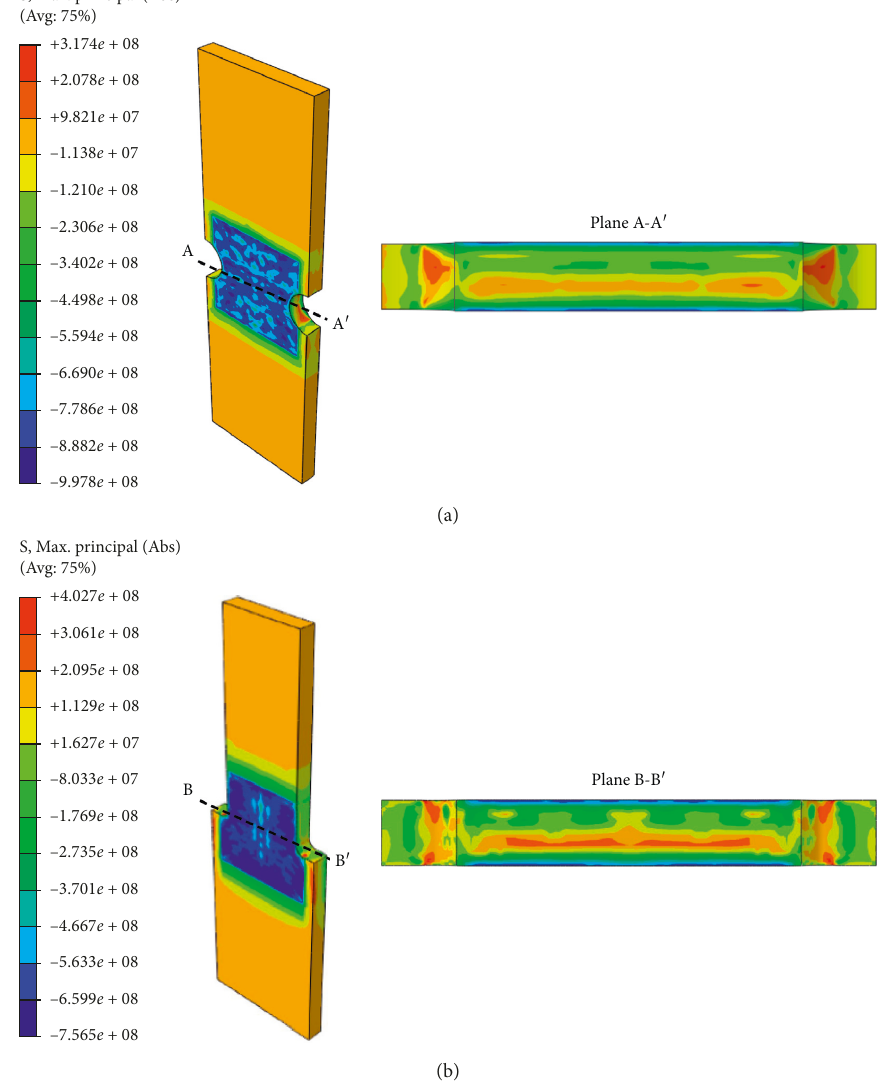
Figure 8: Results of MEF simulation: (a) Residual stress distribution after LSP in notched sample and (b) Residual stress distribution after LSP in filled